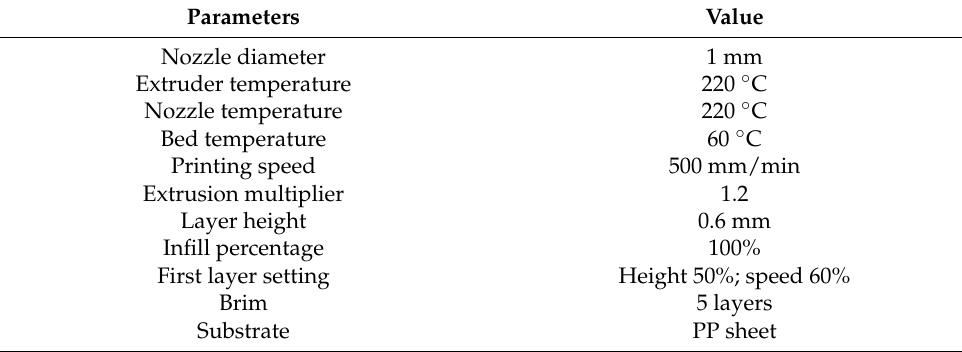
Figure 3. DSC heating and cooling curves (10 °C/min in nitrogen). Table 2. Printing parameters of HDPE and